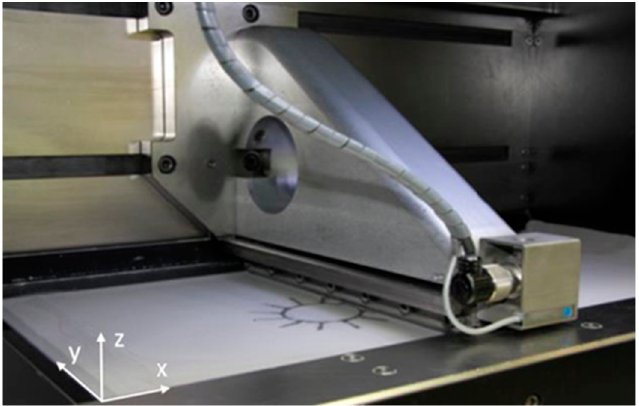
Figure 3. Integration of acceleration sensor at the recoating mechanism [20].